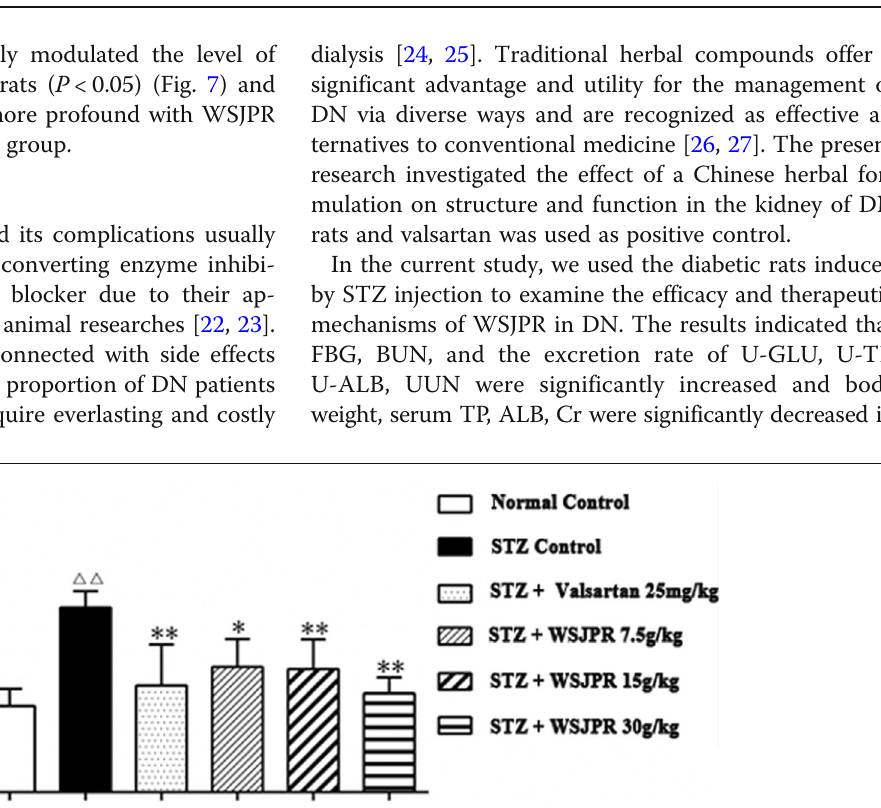
Fig. 3 Effect of WSJPR on the excretion rate of U-GLU ( a ), U-TP ( b ), U-ALB ( c ) and UUN ( d ) in rats at different times ( n = 8). △ P < 0.05, △△ P < 0.01 vs. normal control and * P < 0.05, ** P < 0.01 vs. STZ control; mean ±